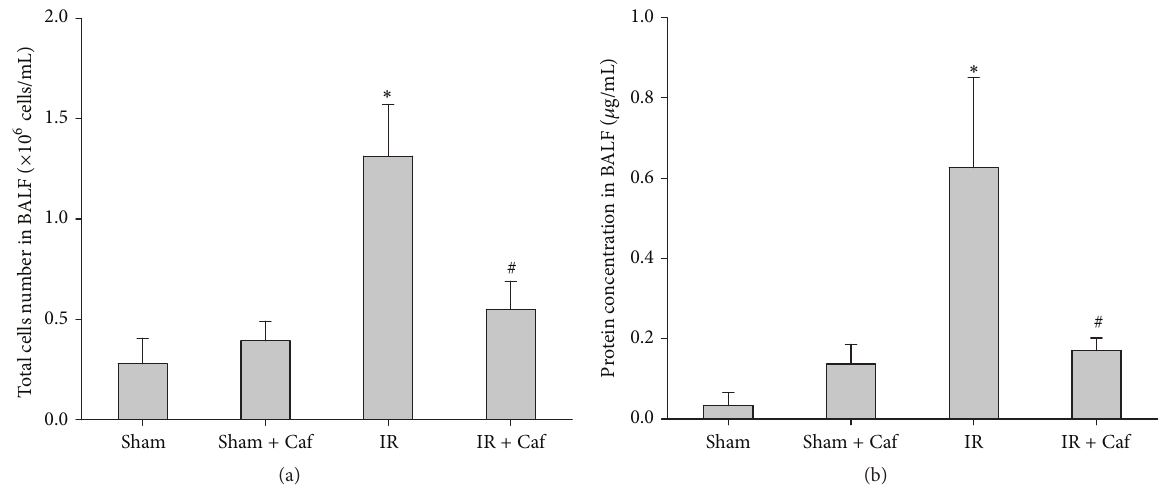
Figure 2: Total cells number (a) and protein concentration (b) in bronchoalveolar lavage fluid (BALF). Sham: the sham-operation group. Sham + Caf: the sham plus caffeine group. IR: the lower limb ischemia-reperfusion group. IR + Caf: the IR plus caffeine group. Rats of the Sham + Caf and the IR + Caf groups received caffeine (50 mg/kg, intraperitoneal injection) immediately after reperfusion. To control for the effects of the treatment vehicle, rats of the Sham and the IR group received normal saline (1.0mL, intraperitoneal injection) at the comparable time point. One-way analysis of variance with the Bonferroni-Dunn test was used for multiple comparisons. The significance level was set at 0.05. Data were derived from 6 rats from each group and presented as mean ± standard deviation. ∗ 𝑃 < 0.05 : the IR group versus the Sham group. # 𝑃 < 0.05 : the IR + Caf group versus the IR